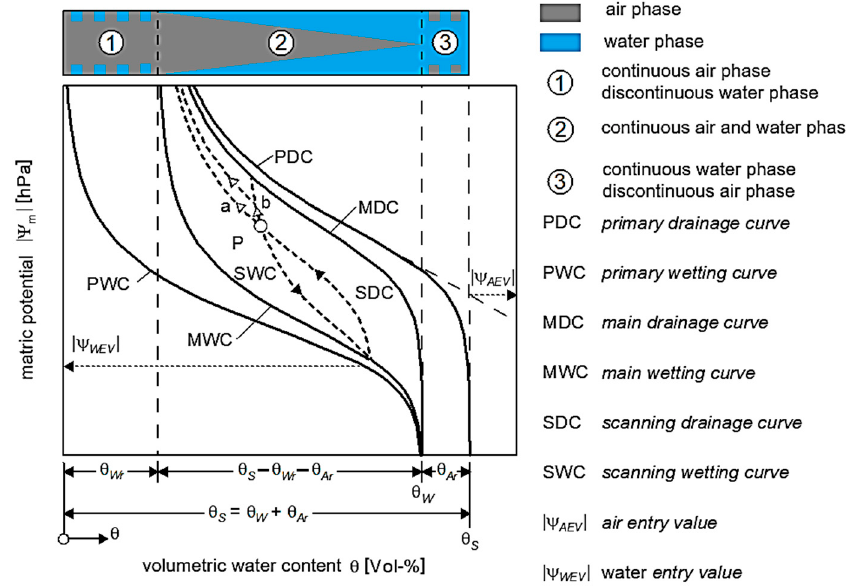
Figure 2. An instance of Soil Water Retention Curve (SWRC), reprinted from Ref. [70] .